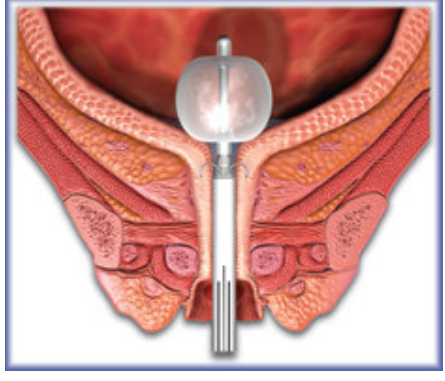
FIGURE 5. Radiofrequency